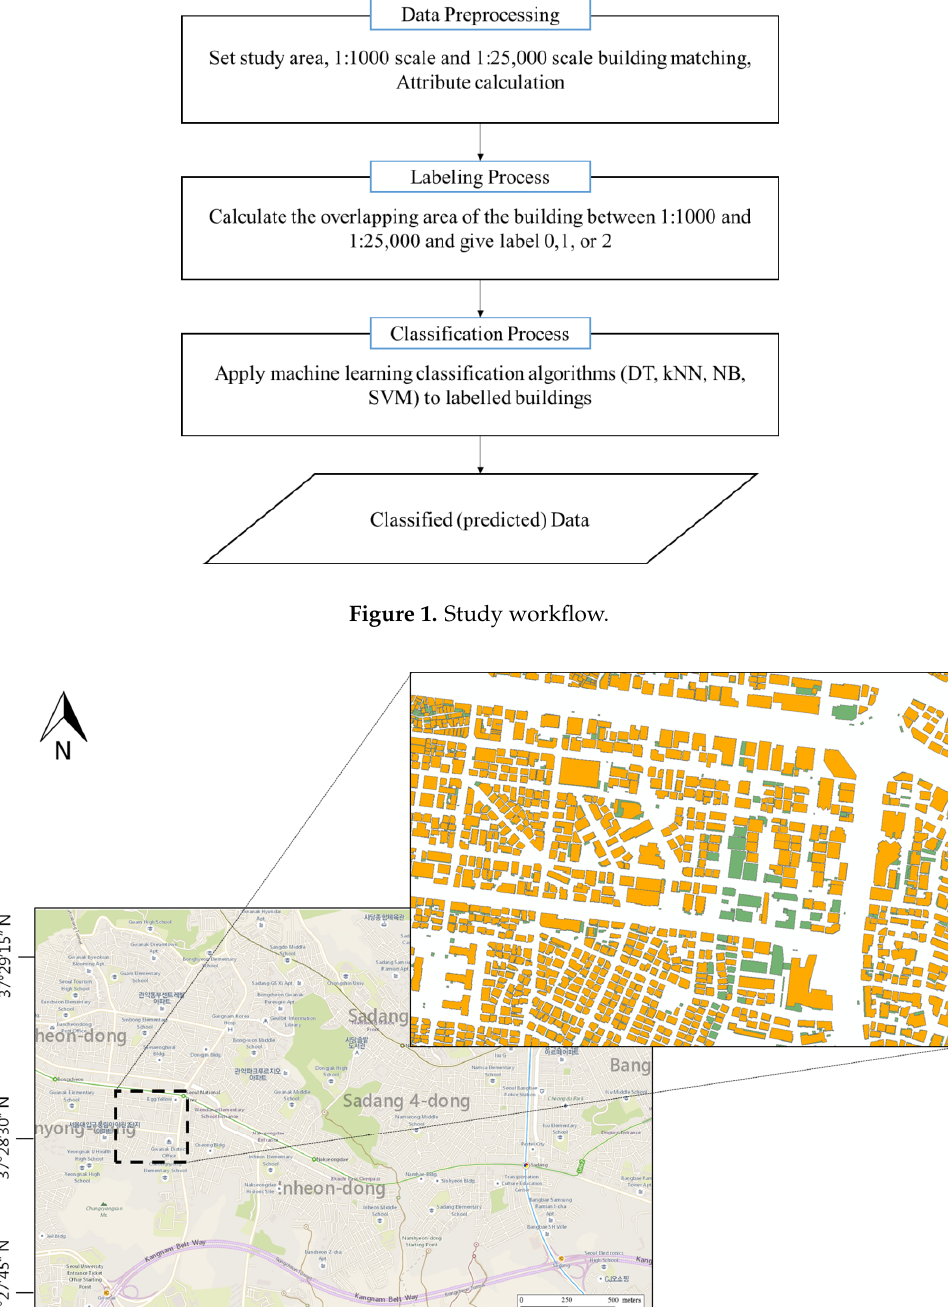
Table 1. Example of 1:1000 digital map building layer